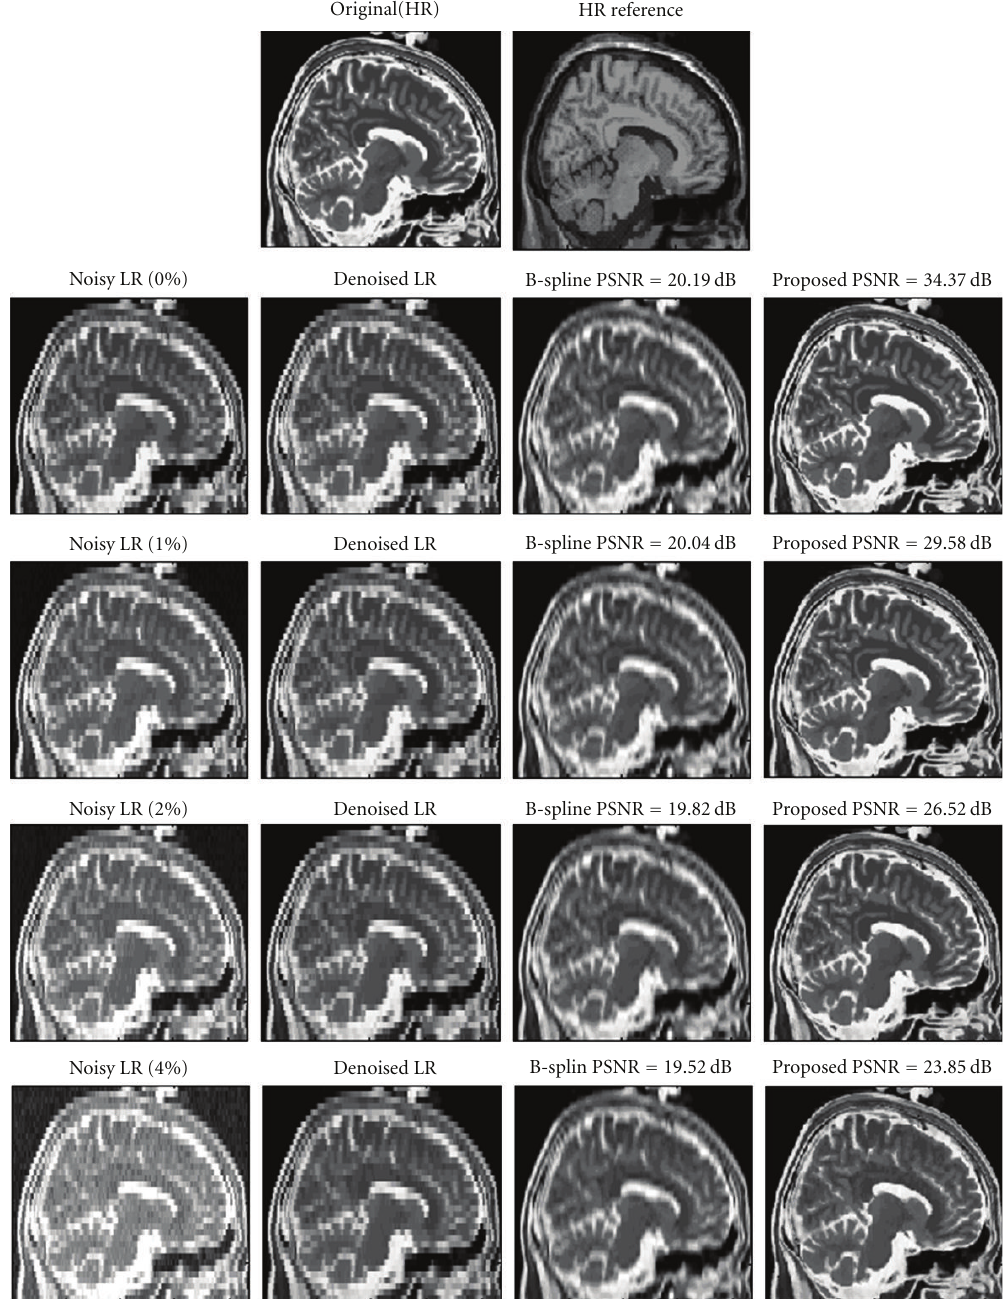
Figure 5: From Top to Bottom, 0, 1, 2, and 4% noise case. From left to right, LR noisy T2-w data, LR-denoised T2-w data, B-spline interpolation, and proposed